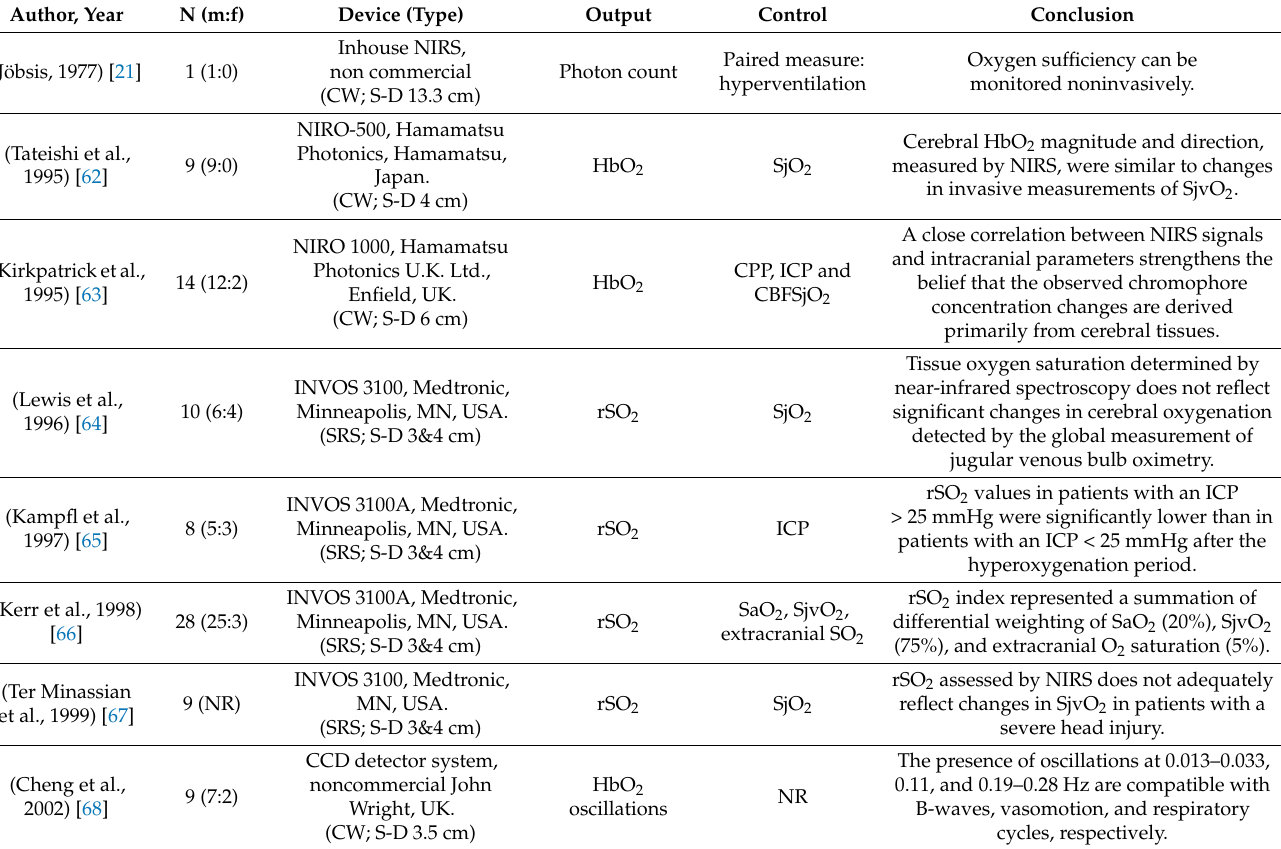
Table 1. Summary of the evidence on NIRS-derived oxygenation in